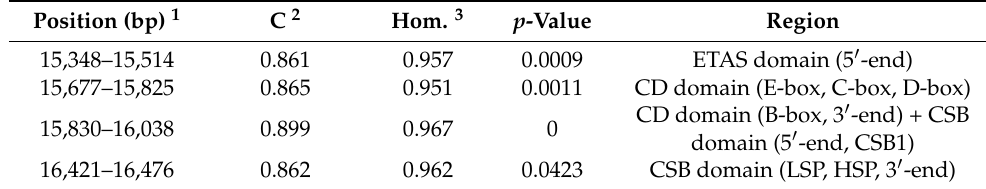
Table 7. Conserved regions identified in the control region of the European mink, European polecat, steppe polecat, black-footed ferret, Siberian weasel, Japanese weasel, mountain weasel, least weasel, stoat, yellow-bellied weasels and long-tailed weasel